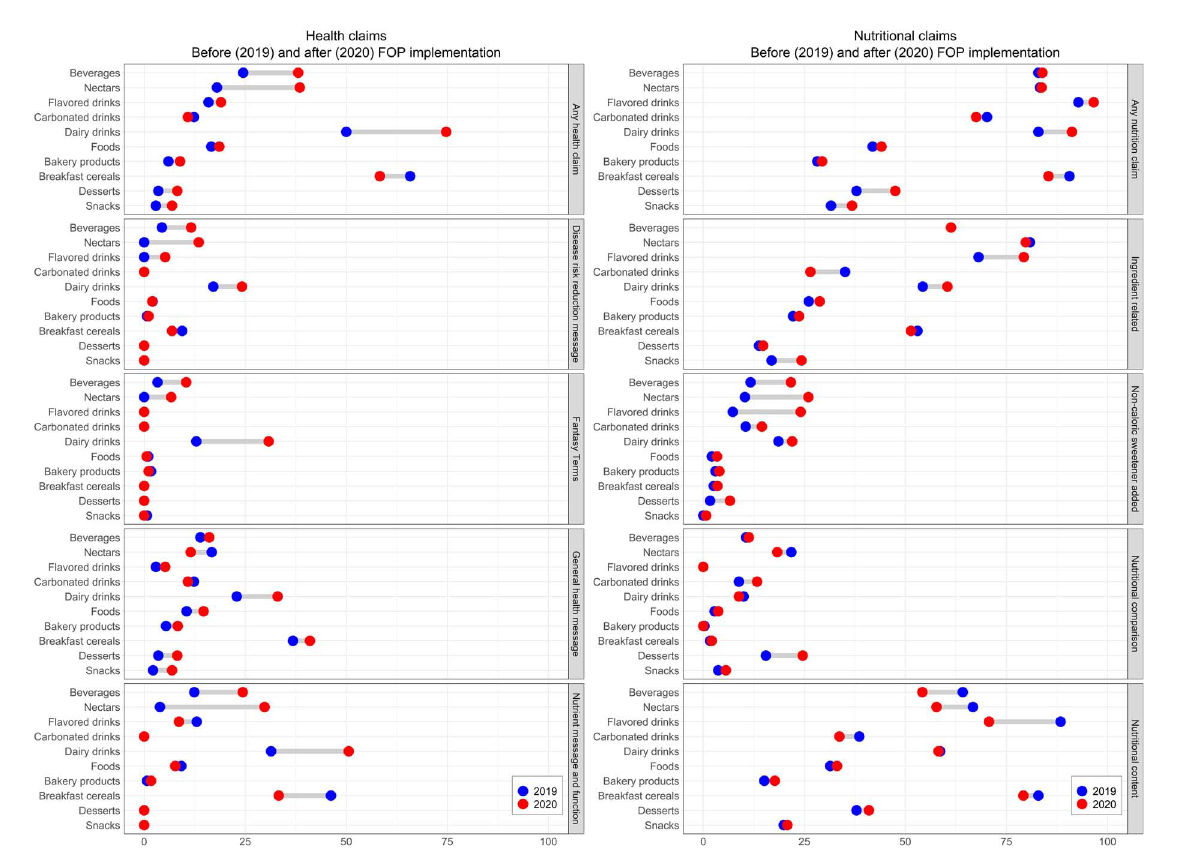
FIGURE3 Health and nutritional claims used before and after the front-of-package warning labels policy implementation, cross sectional